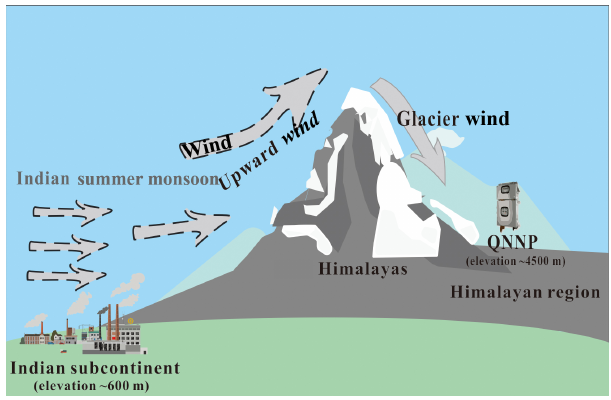
Figure 7. Conceptual map of the transboundary transport of atmo- spheric Hg in the Himalayan region. Arrows show the impacts of the Indian summer monsoon, upward winds and glacial winds on the transboundary transport of